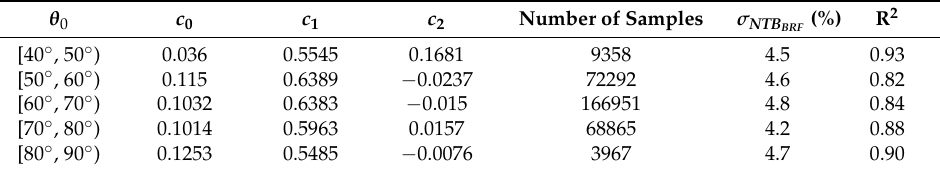
Table 4. Same as Table 3, but for collocated CERES overcast sea ice